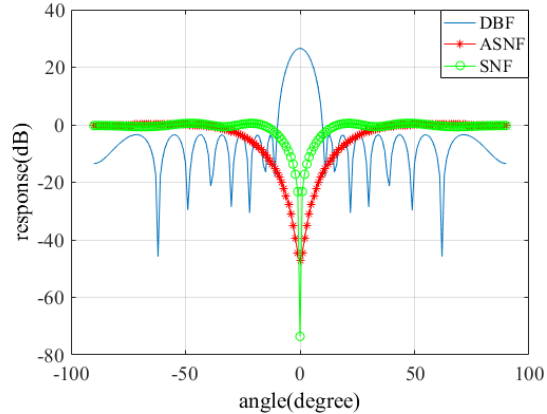
Figure 10. Space responses of DBF and two single notch filters